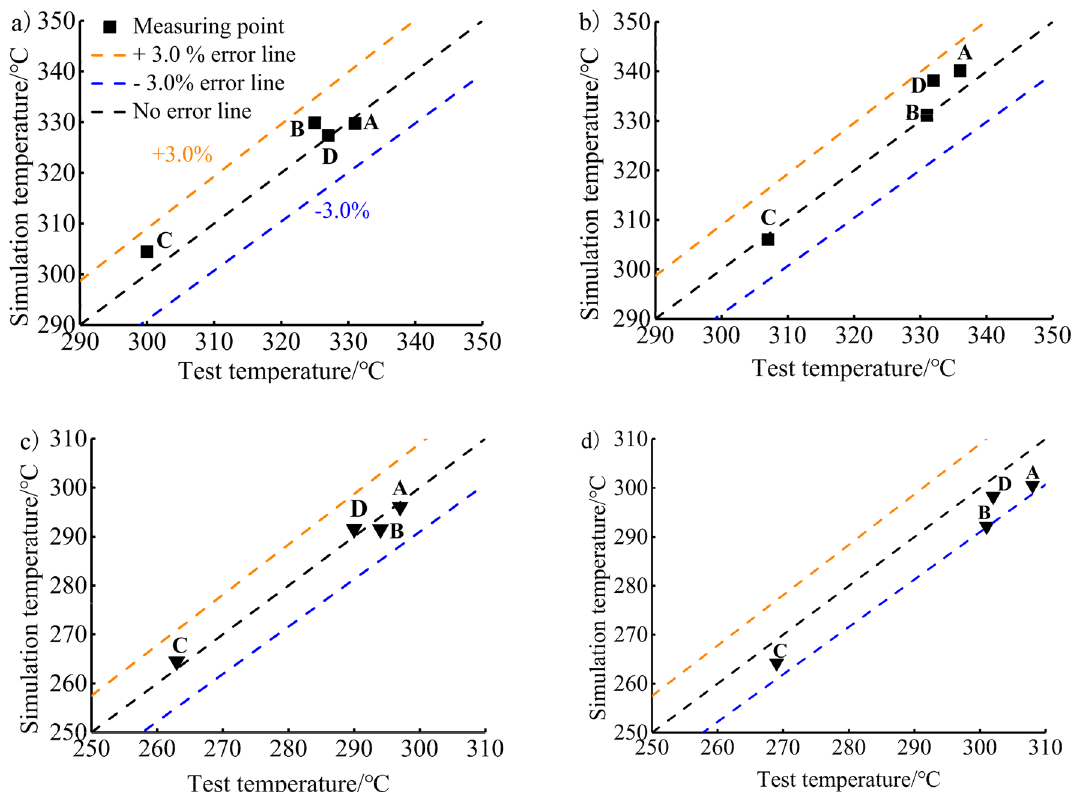
Figure 7. Comparison of experimental test and simulation temperatures of the piston of ( a ) Scheme A, ( b ) Scheme B, ( c ) Scheme C, and ( d ) Scheme D.